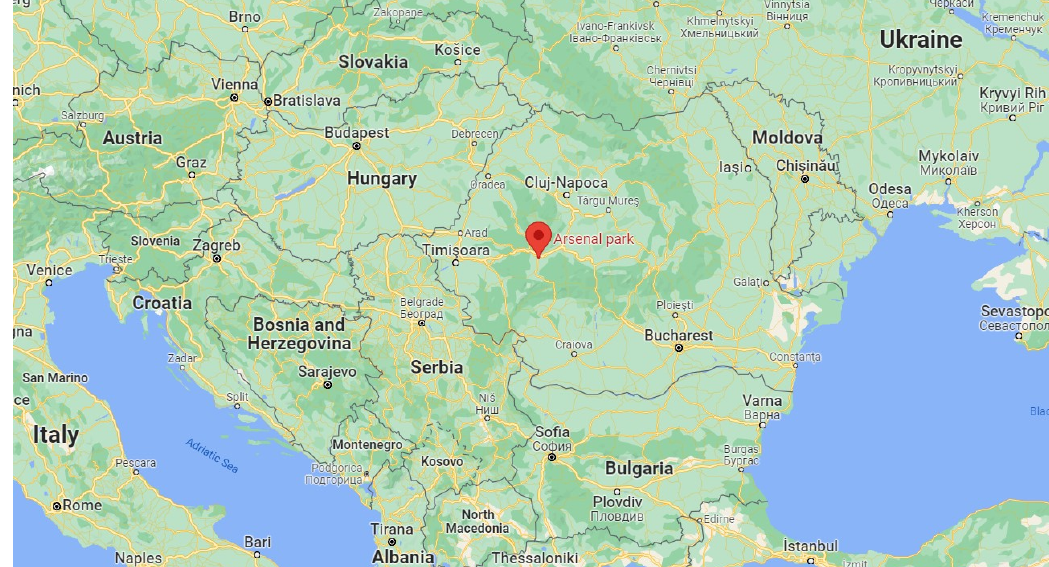
Figure A1. Geographical position of Arsenal Park (Source: https://www.google.ro/maps/ (accesed on: 15 September 2021)).